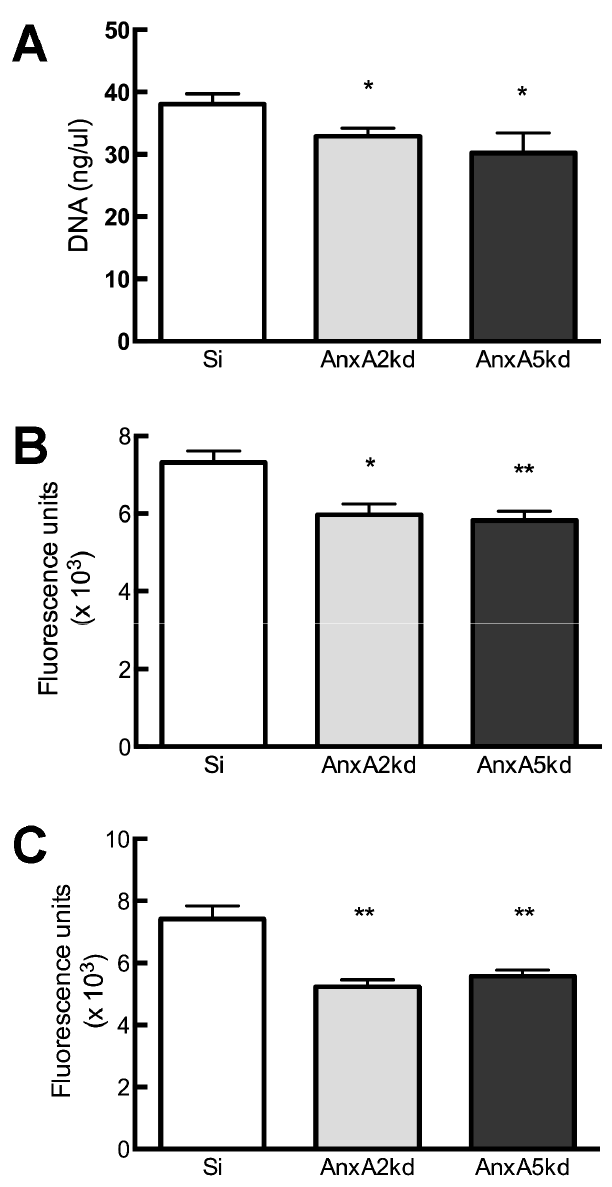
Figure 2. Decreased proliferation in AnxA2 kd and AnxA5 kd cells. (A) Quantification of DNA concentration 24 hrs after cell seeding. Bars represent mean DNA concentration (ng/ m L sample) 6 SEM, n=5–8. (B) Quantification of Calcein-AM fluorescence 24 hrs after cell seeding. Bars represent mean calcein fluorescence units 6 SEM, n=3–8. (C) Quantification of Alamar blue absorbance 48 hrs after cell seeding. Bars represent mean optical density 6 SEM, n=8. *, **represent statistically significant difference from Si, *p , 0.05, **p , 0.01.